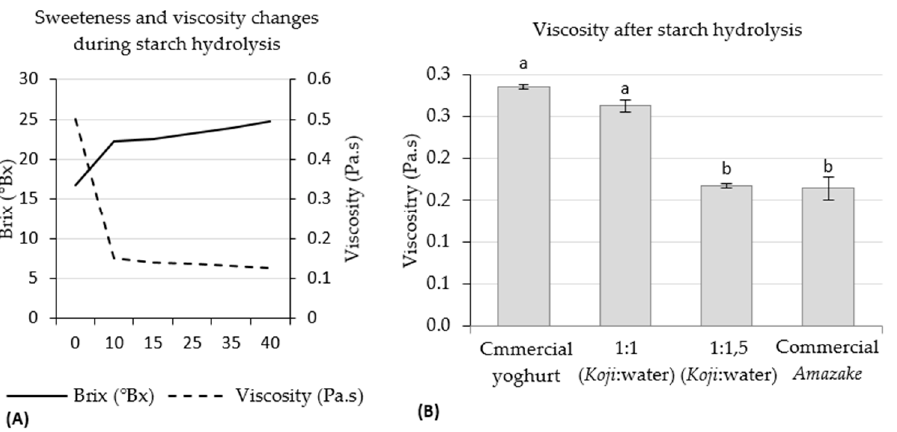
Figure 4. ( A ) Sweetness and viscosity over starch hydrolysis time. ( B ) Viscosity after hydrolysis in the selected Koji :water concentration and its comparison with drinking yoghurt and Amazake . a, b—homogeneous groups according to the Tukey’s post hoc test at a 95% con fi dence level.